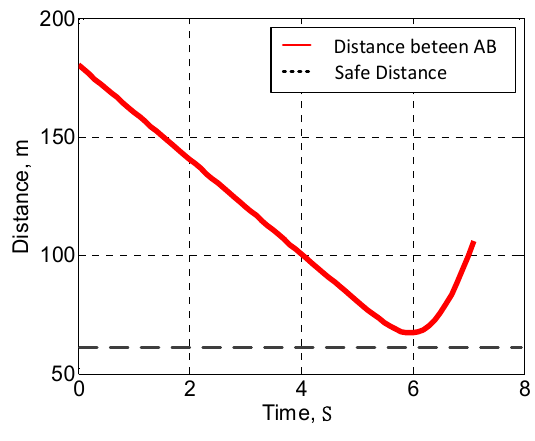
Figure 8. Relative distance.